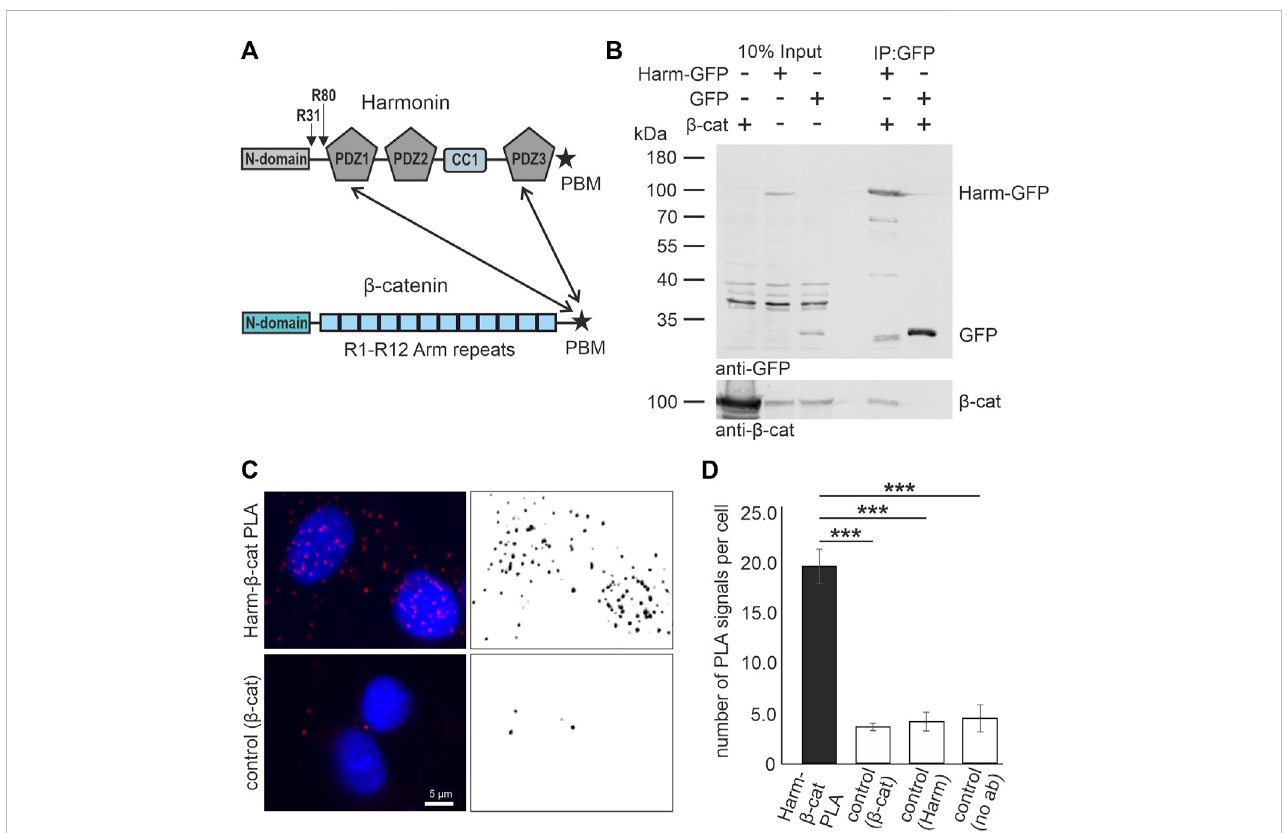
FIGURE 1 In vitro and in situ interaction of harmonin with β -catenin. (A) Schematic representations of the domain structures of the scaffold protein USH1C / harmonin (isoform a) and β -catenin ( β -cat). Pathogenic USH1C mutations c.91C > T; p.(R31*) and c.238dupC; p.(R80Pfs*69) are highlighted. Twoheaded arrows indicate that theC terminal PDZ (PDZ; PSD-95, DLG, and ZO-1) The pathogenicnonsense mutations c.91C > T; p.(R31*) and c.238dupC; p.(R80Pfs*69) in USH1C referredtointheStudyarehighlighted.Bindingmotif(PBM)of β -cateniniscapabletobindtothePDZ1andPDZ3ofharmonin. (B) Westernblot analysis of a representative GFP-Trap ® demonstrates interaction between harmonin a1-GFP (Harm-GFP) and β -catenin ( β -cat) from lysates of HEK293T cells transfected with β -cat and Harm-GFP, or GFP, respectively. Harm-GFP but not GFP alone pulled down β -catenin; N = 3 experiments. (C) Representative fl uorescence image of PLA signals (red, left) in HEK293T cells demonstrates interaction of intrinsic harmonin (Harm) and β -cat (upper panel). Signal is signi fi cantlydecreasedinthecontrolusingonly β -catantibody(lowerpanel).CellnucleiaremarkedwithDAPI(blue). (D) Statisticalanalysisrevealsanincrease in number of signals of 4-fold in the PLA compared to all three controls (Supplementary Figure S1). Two-tailed Student ’ s t -test, *** p ≤ 0.001; N = 3